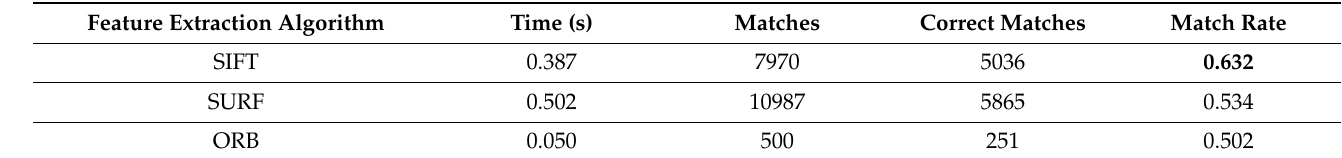
Table 3. Results of the image matching by adding salt and pepper noise randomly. the image changed brightness. The best result is marked in bold.